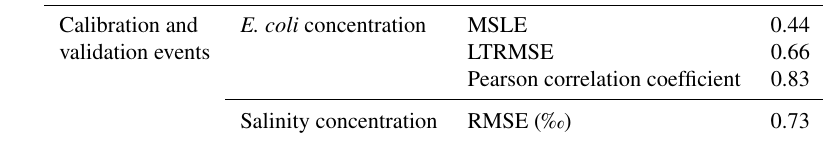
Table 4. Hazard criteria based on E. coli concentration in seawater.